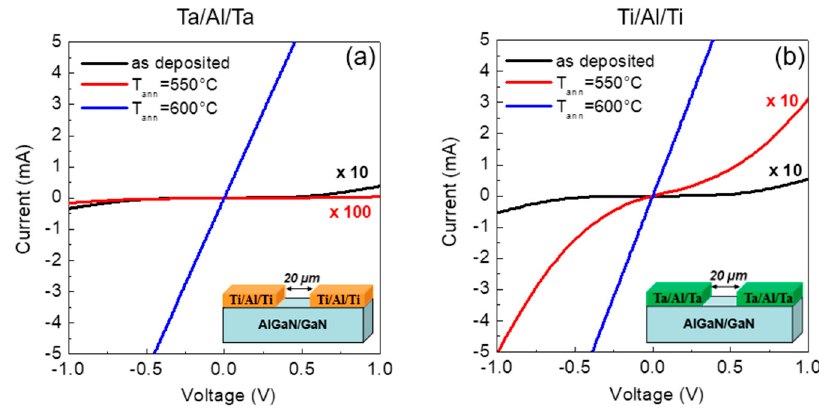
Figure 1. Current–voltage (I–V) curves acquired on pads of Transmission Line Model (TLM) structures at a distance of 20 µm in ( a ) Ta/Al/Ta and ( b ) Ti/Al/Ti treated at different annealing temperatures (as deposited, 550 °C and 600 °C).